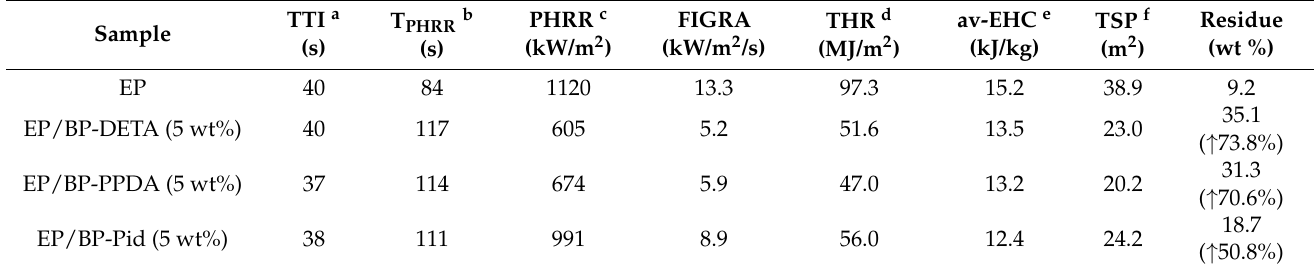
Figure 7. ( a ) HRR, ( b ) THR, ( c ) TSP and ( d ) Weight versus time curves of the pure EP and EP/BP-NH 2 nanocomposites from cone calorimeter tests. Table 3. The data from the cone calorimeter test of pure EP and EP/BP-NH 2 nanocomposites at a heat flux of 50 kW/m 2